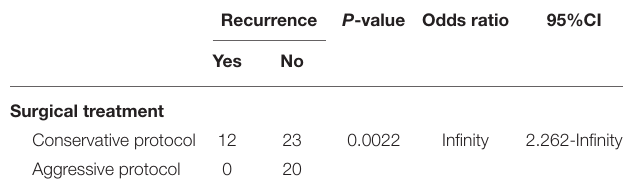
TABLE 3 | Relationship of surgical protocol and recurrence rate (Fisher’s exact